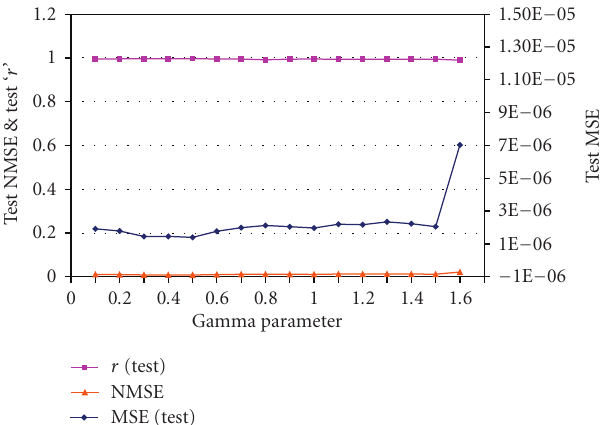
Figure 3: Choice of Gamma (CSTR Benchmark Data).